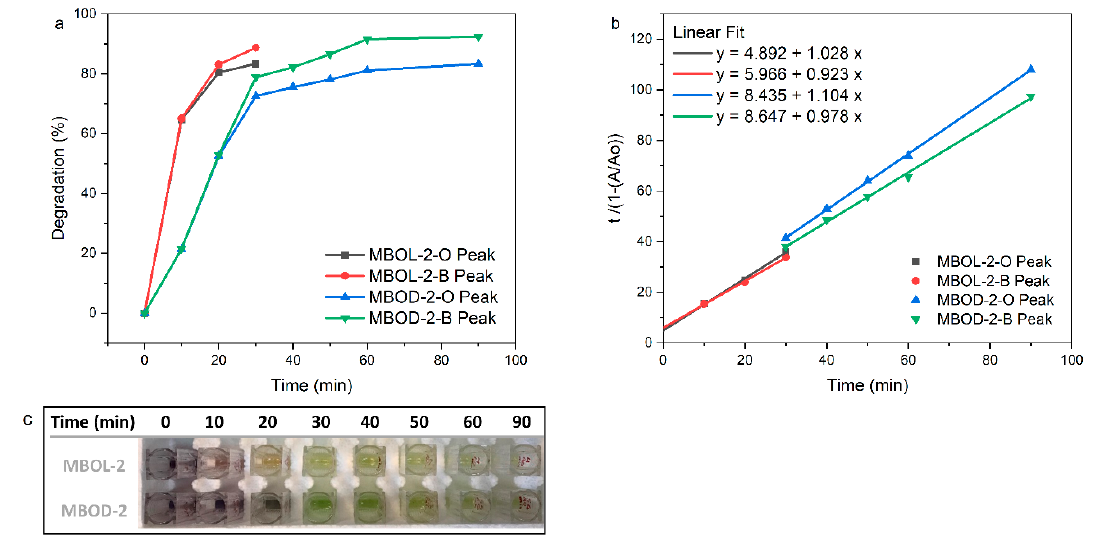
Figure 6. ( a ) The percentage of the MB/MO mixed dye degradation, ( b ) the linear fitting of the MB/MO experimental data with the BMG kinetic model and ( c ) photographs of the degraded MB/MO mixed dye during 90 min by the same catalyst in different pH values under sunlight and in darkness.